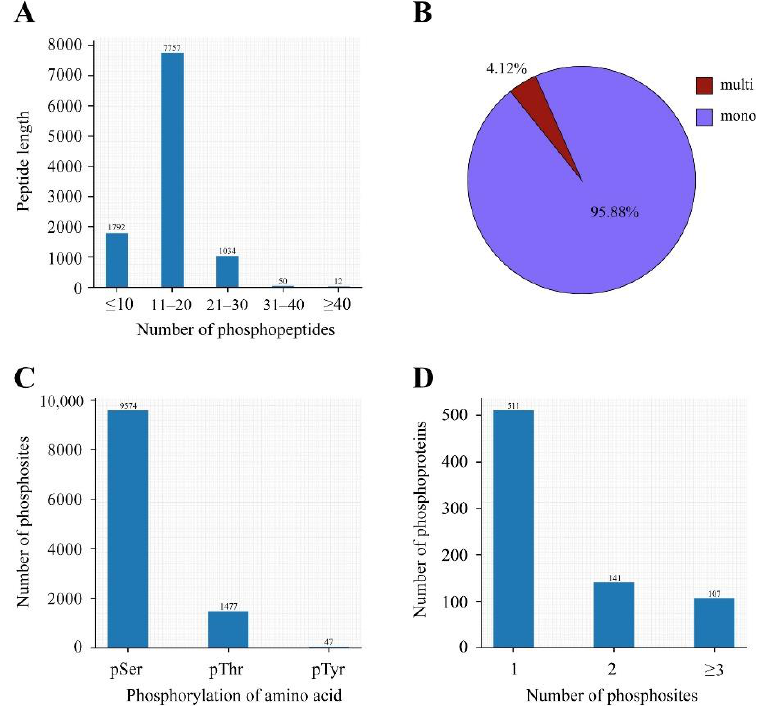
FIGURE 1. Large-scale information regarding the phosphoproteomic research between sporulated oocysts and tachyzoites of the T. gondii PYS strain. ( A ) The distribution of phosphopeptides on different peptide lengths. ( B ) The proportion of mono-phosphosites and multi-phosphosites among total phosphopeptides showed that a large part of the phosphopeptides have single phosphosites. ( C ) Proportion of the pSer/pThr/pTyr phosphoproteome. Phospho-pSer, phospho-pThr, and phospho-pTyr accounted for 86.27% of all phosphosites, 9.28% of all phosphosites, and 0.42% of all phosphosites, respectively. ( D ) Distribution of phosphosites on phosphoproteins. Most phosphoproteins included single phosphosites.